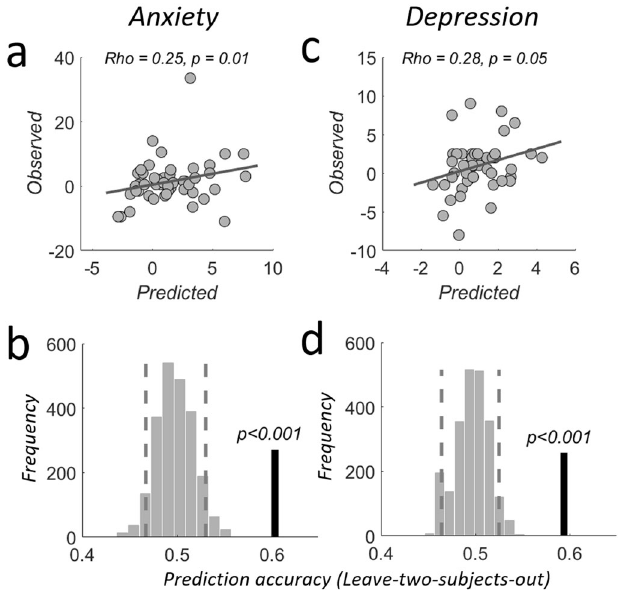
Fig. 4 Out-of-sample prediction of mean symptom severity changes. a Correlation between out-of-sample predicted and observed mean anxiety symptom severity changes due to emergency room internship stress.